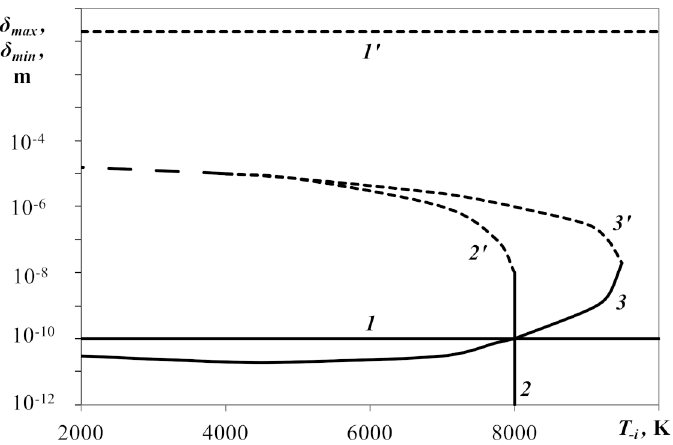
Figure 3. Distances between surfaces of charged droplets δ max and δ min , respectively, at points of maximum and minimum free energies of the droplet (curves 1 (cid:48) , 1 ), positive ion ( 2 (cid:48) , 2 ) and all charge carriers ( 3 (cid:48) , 3 ), subject to temperature T − i . Z = 500, T − z = T +i = 300 K, R − z = 10 − 6 m, R − i = R +i = 10 − 10 m, χ =